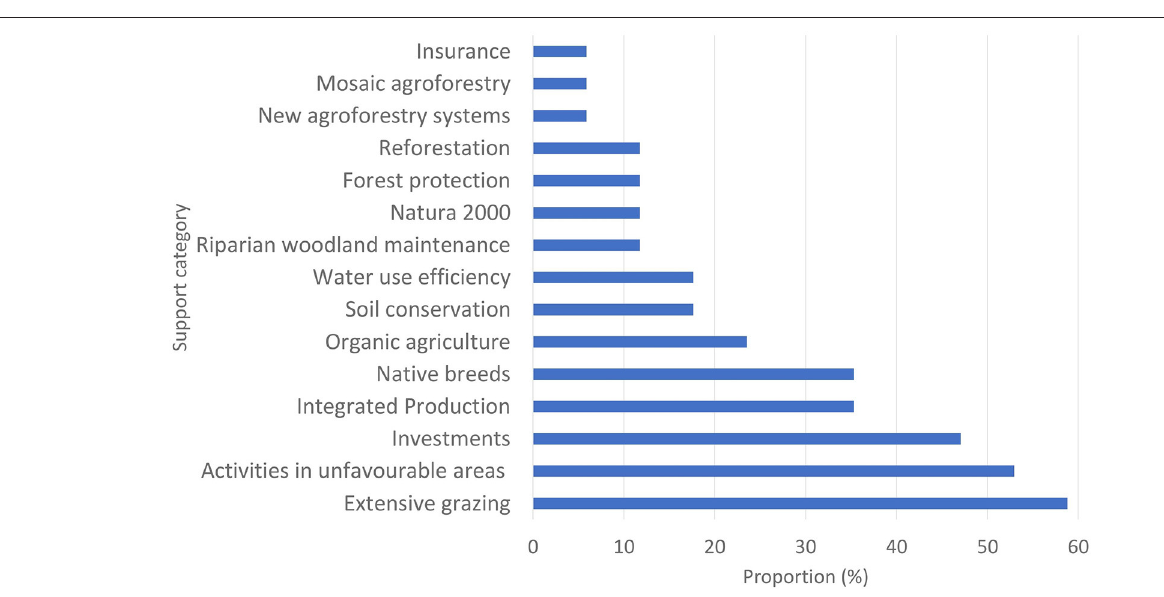
FIGURE 5 | Distribution of financial support according to categories within the CAP.